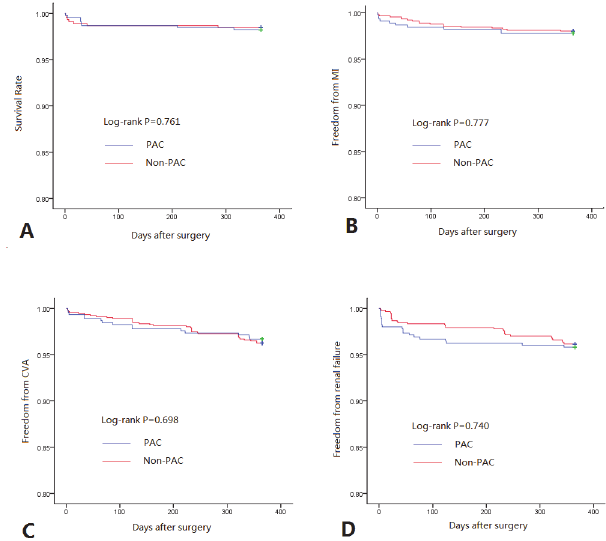
Fig 1. Long-Term Outcomes according to PAC status. A. Survival rate B. Freedom from myocardial infarction (MI) C. Freedom from cerebrovascular accident (CVA) D. Freedom from renal failure.